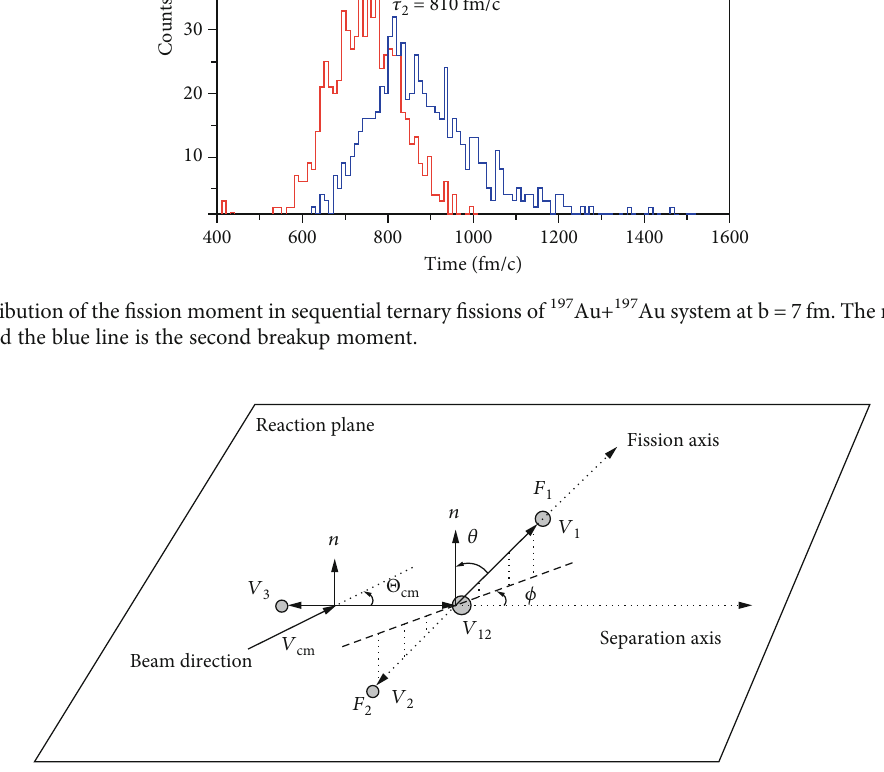
Figure 6: The schematic view of the reaction in a sequential ternary fi ssion, in which a TLF and PLF are formed in the primary deep-inelastic process and followed by a consecutive breakup process from one of these two fragments. The de fi nitions of the in-plane ( ϕ ), the out-of-plane ! ( θ ), and ( Θ ) angles are shown. The normal direction n is the unit vector of reaction plane. The beam, separation and fi ssion axes, and their cm ≥ v orientations are displayed, and the orientation of the fi ssion axis is given by the larger z -axis velocity v 1 z 2 z